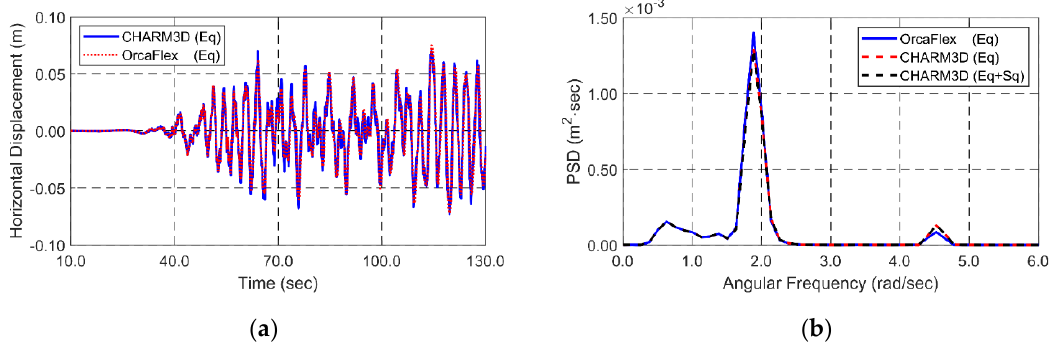
Figure 12. Time histories (without seaquake) ( a ) and spectra ( b ) of horizontal tunnel responses at the middle location under seismic excitations